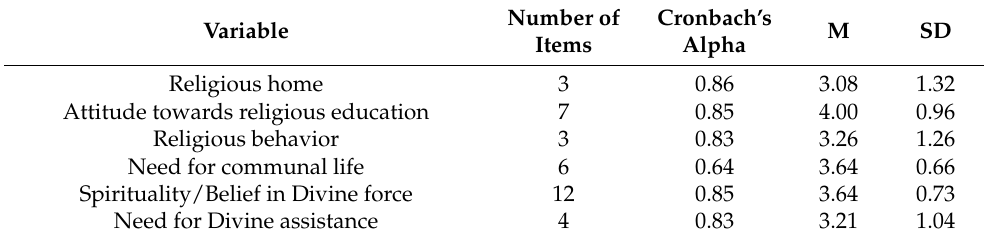
Table 2. Cronbach’s alpha, means, and standard deviations of the questionnaire